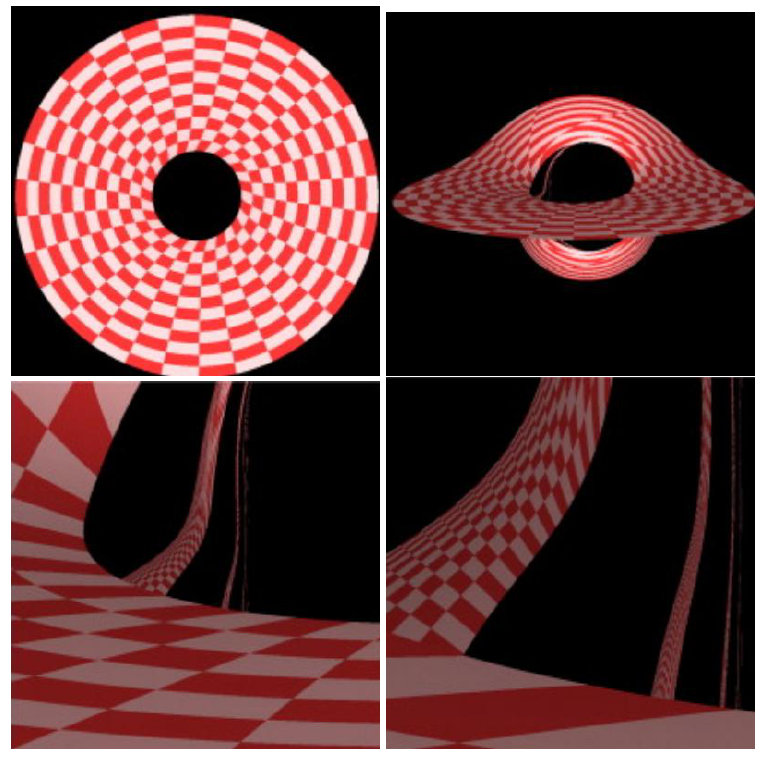
Figure 2. Ray-tracing of a thin accretion disk around an extreme Kerr black hole with mass M = 1 and Kerr parameter a = 1. The observer is located at a distance of 50 M at inclination angles of 2deg (left) and 80deg (three right panels) with respect to the normal disk. The inner and outer disk radii are r in = 3 M and r out = 15 M . Higher-order images of the disk become visible within a field of view of 5deg (second from right) and 1.5deg (right). Figure reprinted from Reference [38] with permission from